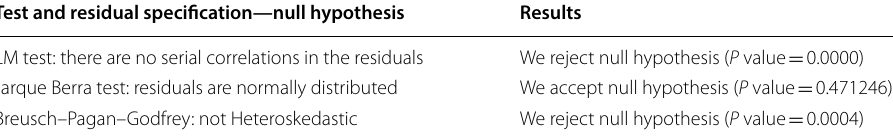
Table 4 Residual diagnostic result of the first model. Source : Calculated by the author Test and residual specification—null hypothesis Results